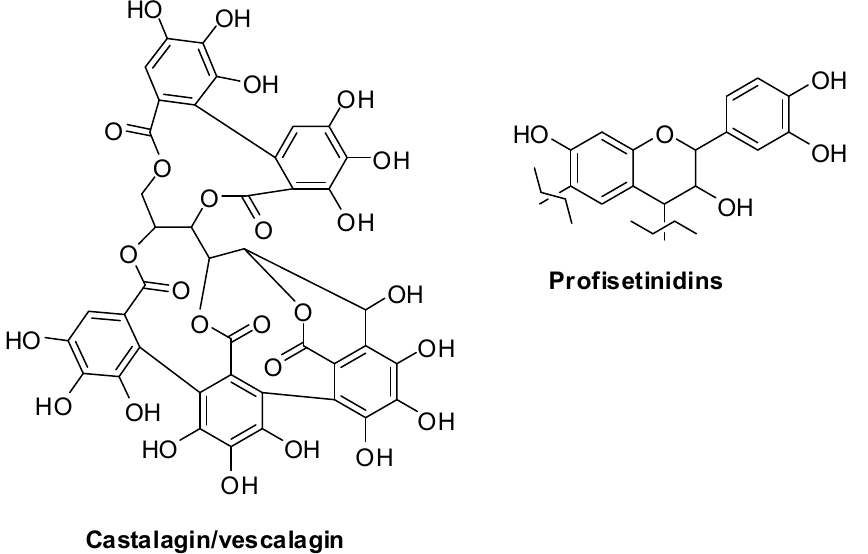
Figure 1. Representative structures of the main tannins occurring in chestnut and quebracho wood.